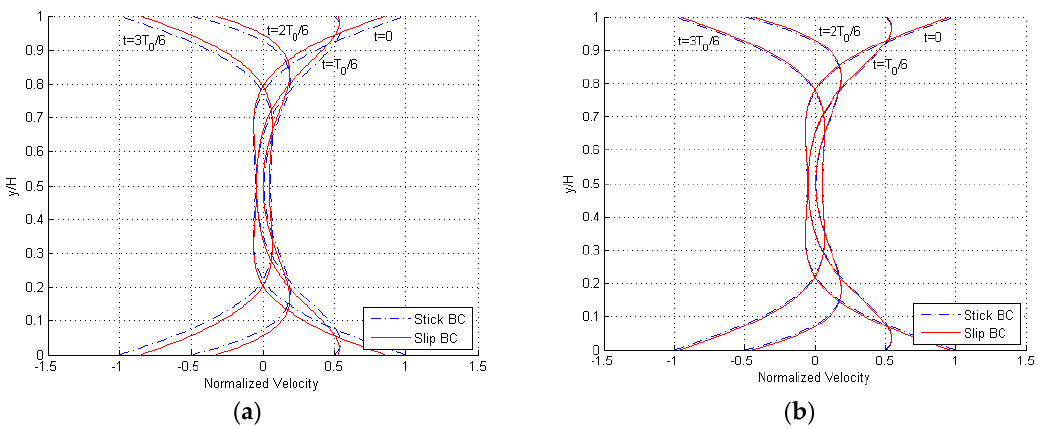
Figure 4. Disengaged solution, ( a ) H = 3 µ m and ( b ) H = 12 µ m: snapshots of the velocity profile during a single cycle of oscillation of the two plates, for f = 100 f d and both stick and slip BCs.